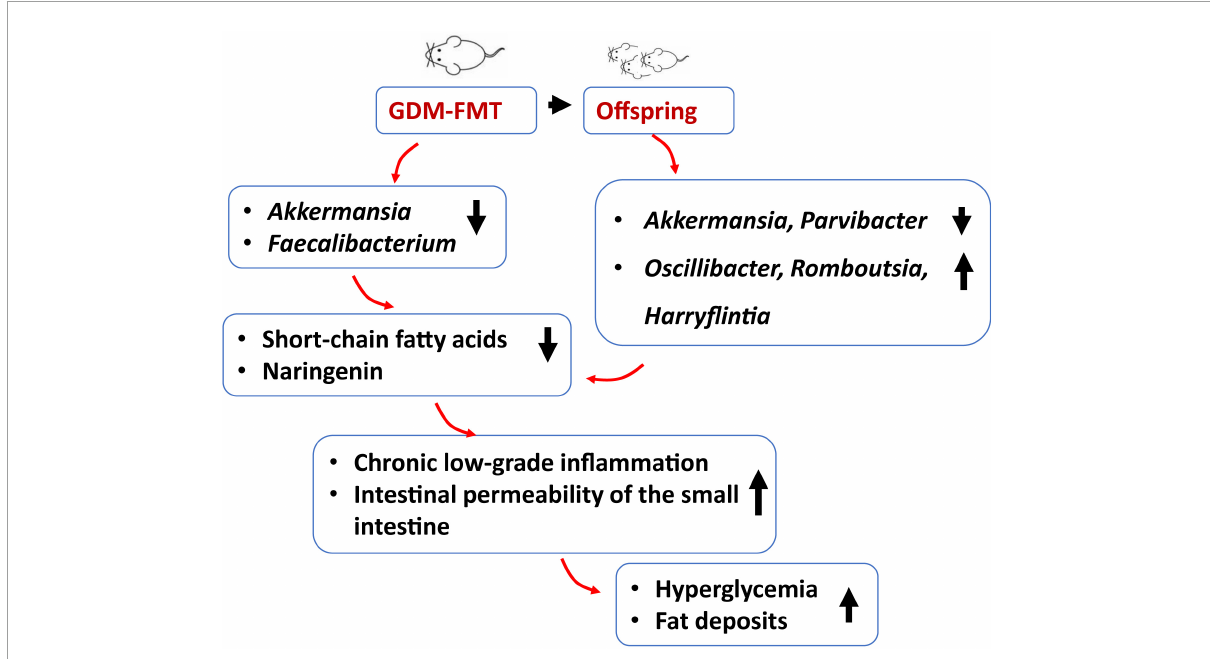
FIGURE6 Schematic diagram of GDM gut microecological